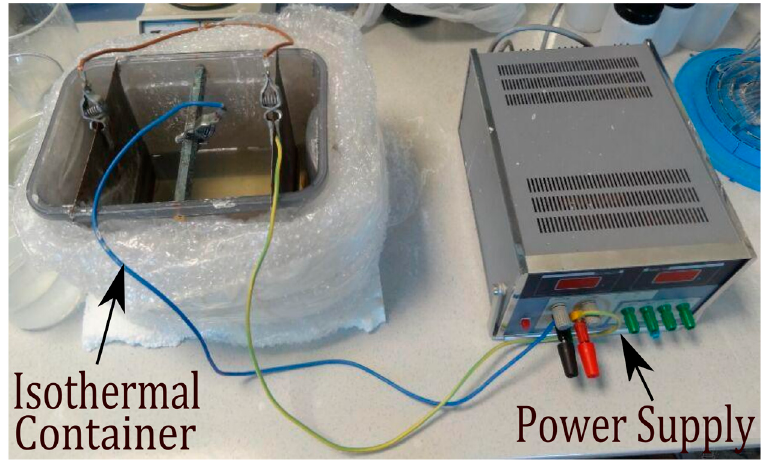
Figure 2. Details of the isothermal container and the power supply used in electroplating of the phosphate screws.